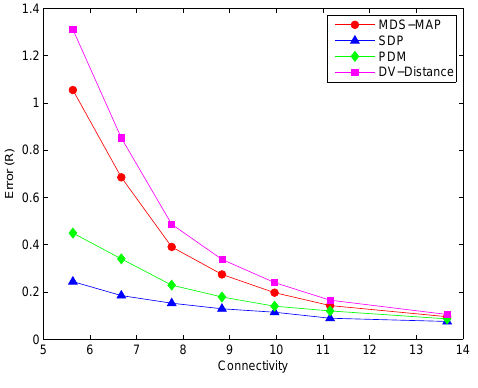
Figure 1 . 50-node networks, 10 anchors, measurement error=5%.